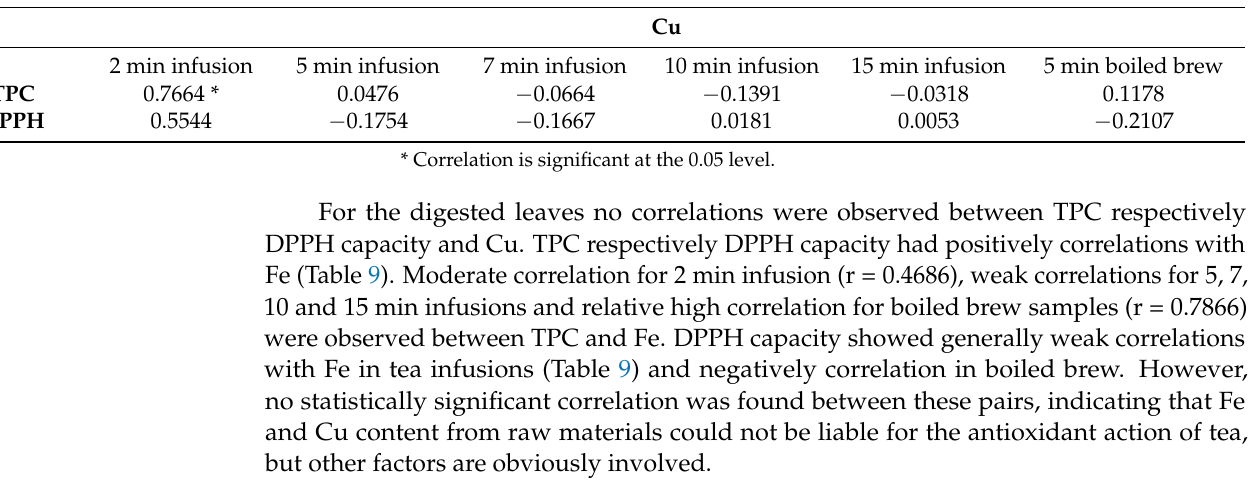
Table 8. Correlation coefficient of antioxidant activity and Cu in studied tea plant infusions. Pearson Correlation Coefficient (r)